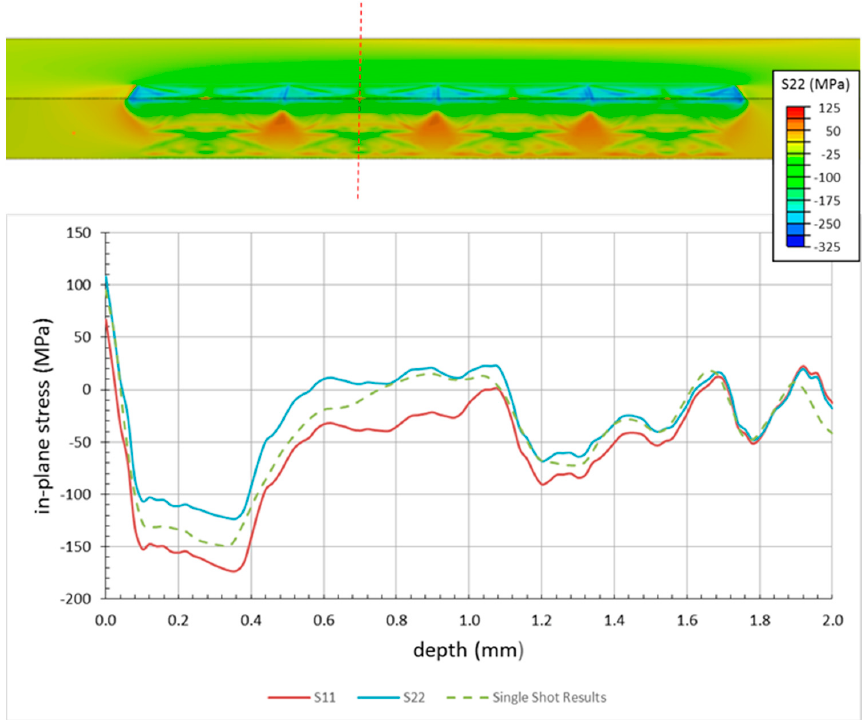
Figure 7. Comparison of stress profiles between a single peen spot and a peen line.